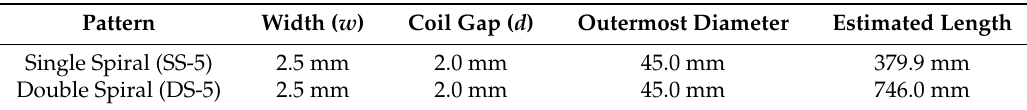
Table 3. Spiral sizing parameters (see Figure 5b).